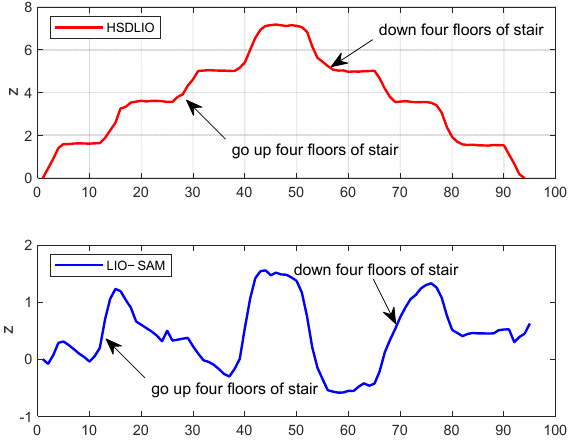
Figure 12. Comparison of LeGO-LOAM, LIO-SAM, and HSDLIO trajectories. The red line is the trajectory of HSDLIO, the blue line is the trajectory of LIO-SAM, and the black line is the trajectory of LeGO-LOAM. While LeGO-LOAM’s trajectory drifted and LIO-SAM’s trajectory produced cu- mulative errors in the z direction, the trajectory of HSDLIO approximated the real trajectory.